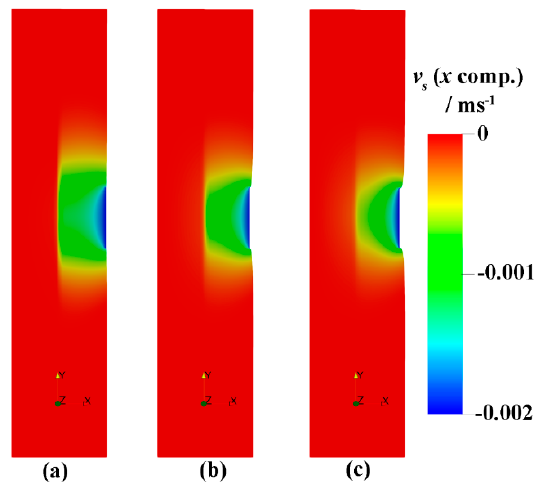
Figure 7. The distribution of the horizontal component of the solid velocity, v s , at different times after punching starts: ( a ) 1 s, ( b ) 3 s, ( c ) 5 s.